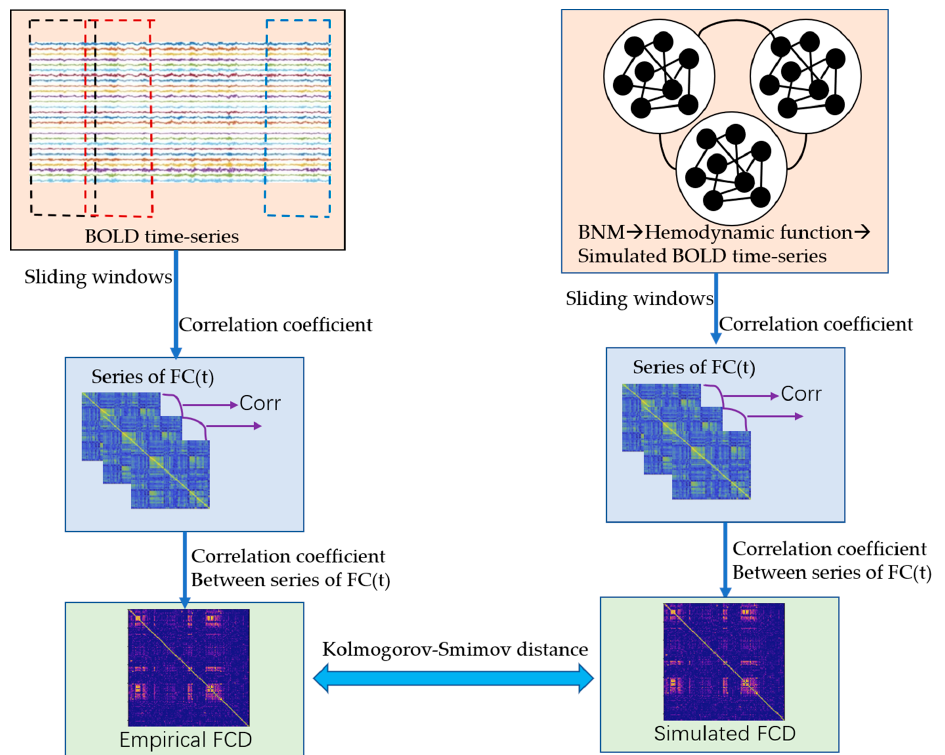
Figure 3. Model fitting through dynamic FC. Sliding window is the commonly used method to analyze dynamic FC. For simulated or empirical BOLD time-series, the window is slid over the entire time-series and FC matrices at each sliding window are computed to obtain series of FC. Next, the FC matrices at different time windows are compared with each other using a pairwise correlation to form another matrix called FCD matrix where each axis encodes time points of the series of FC. To fit the BNM, the Kolmogorov–Smirnov distance between empirical and simulated FCD distributions is minimized [65,75].